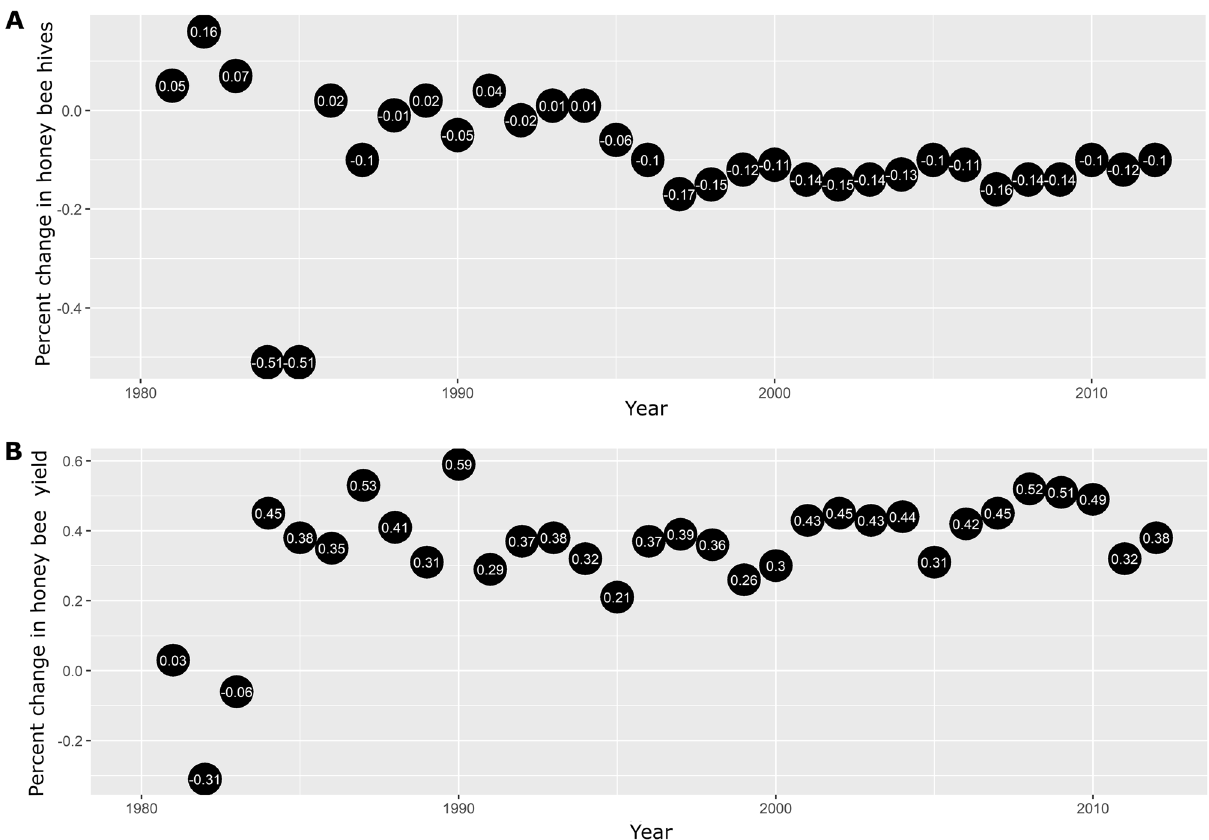
Figure 5. Temporal variations in the percentage change in the number of hives in Mexico based on the population in